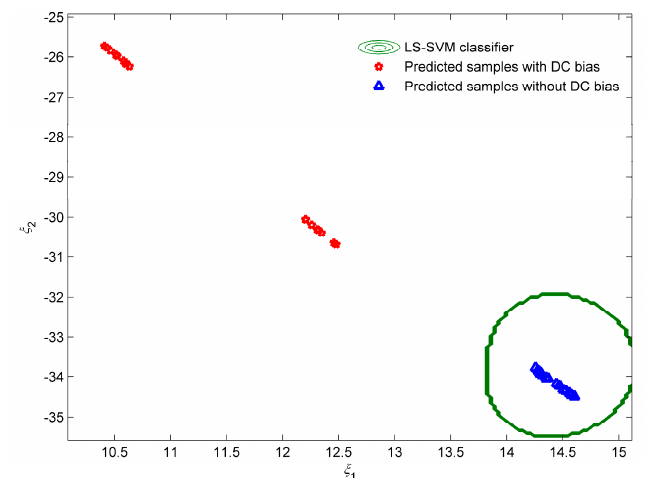
Figure 9. Recognition result of the LS-SVM classifier.